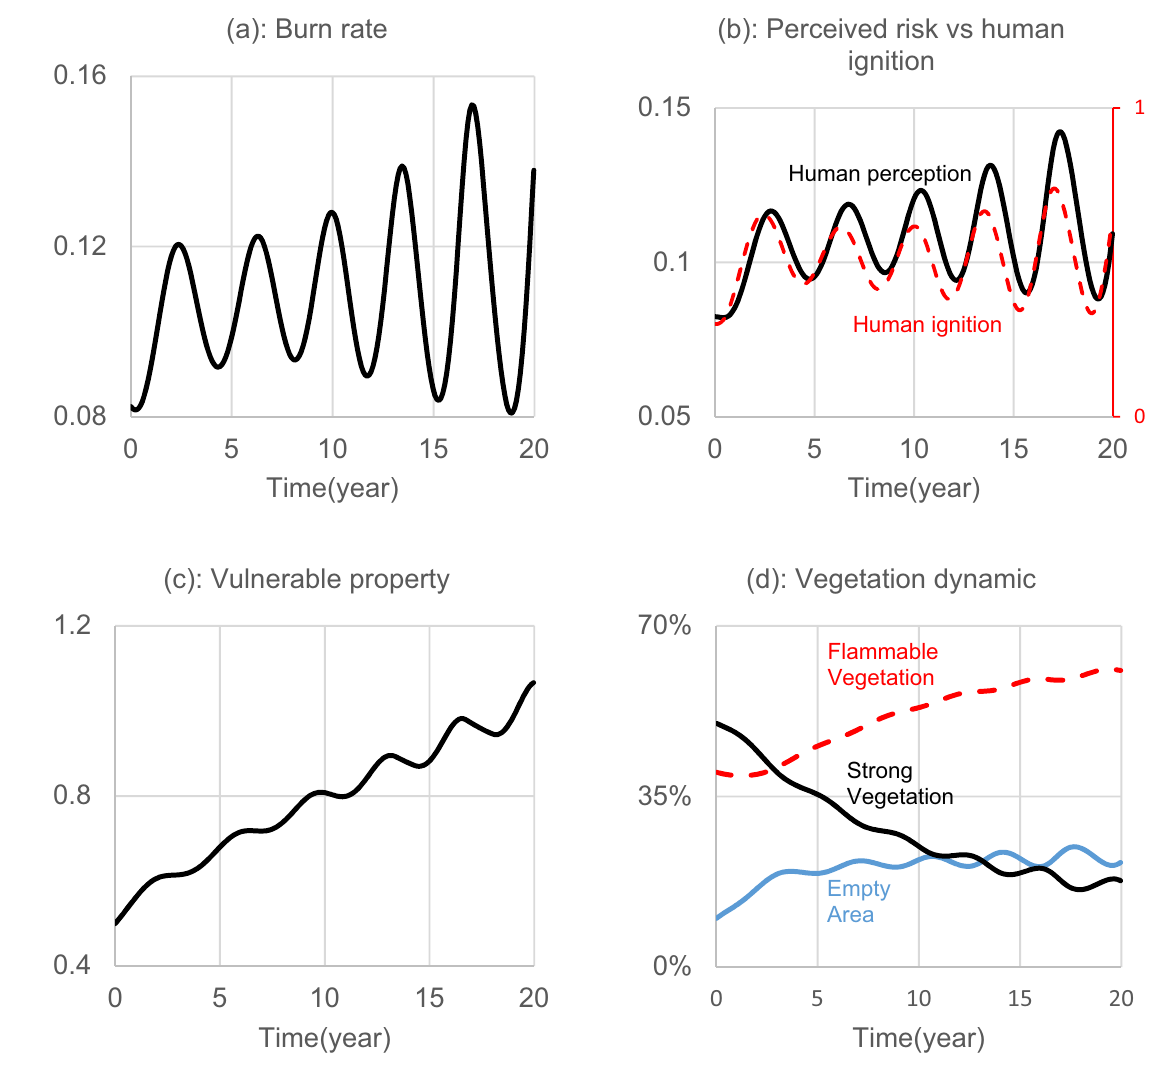
Figure 6. Base run simulation for a 20-year run of the